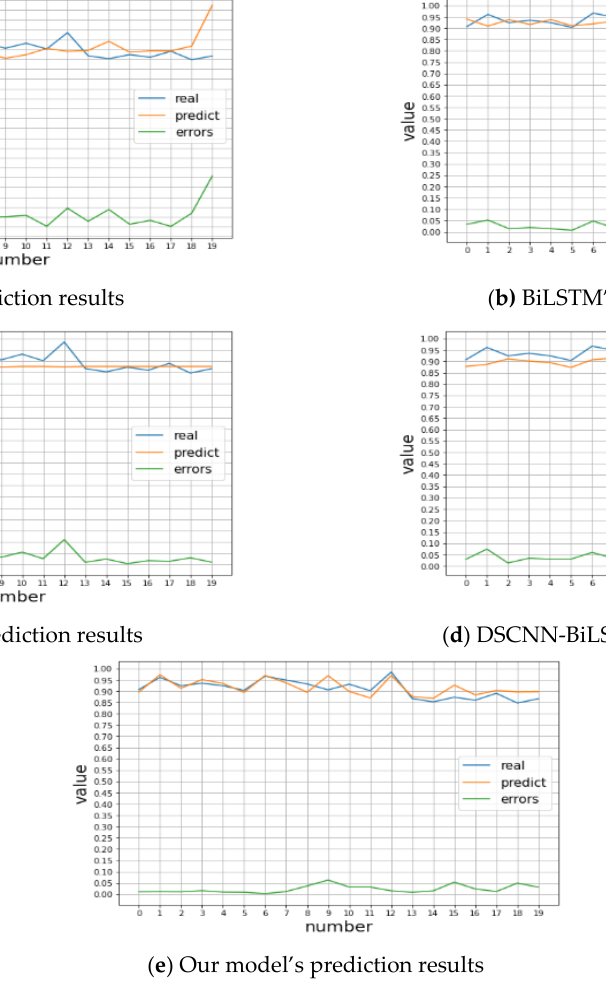
Figure 12. Graph of predicted results of different models.